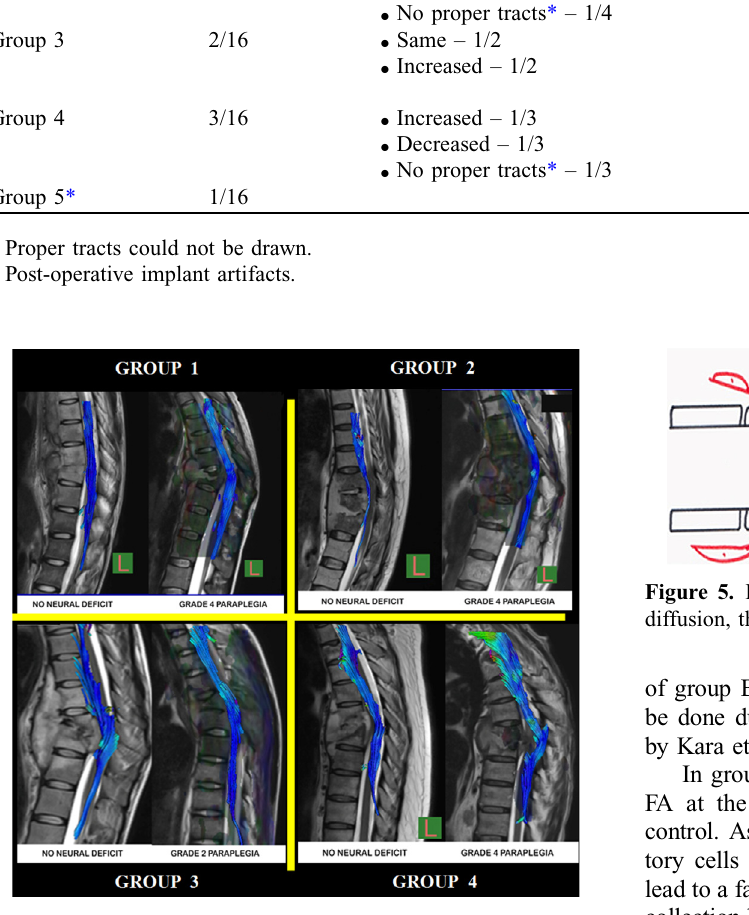
Figure 4. Three-dimensional tractography image acquired in the medio-lateral plane superimposed on sagittal T2WI images shown for each group. Subjective assessment of tract volume at and below site of lesion (SOL) as compared to above SOL shows that in each group, similar images are seen among patients without and with neural deficit.